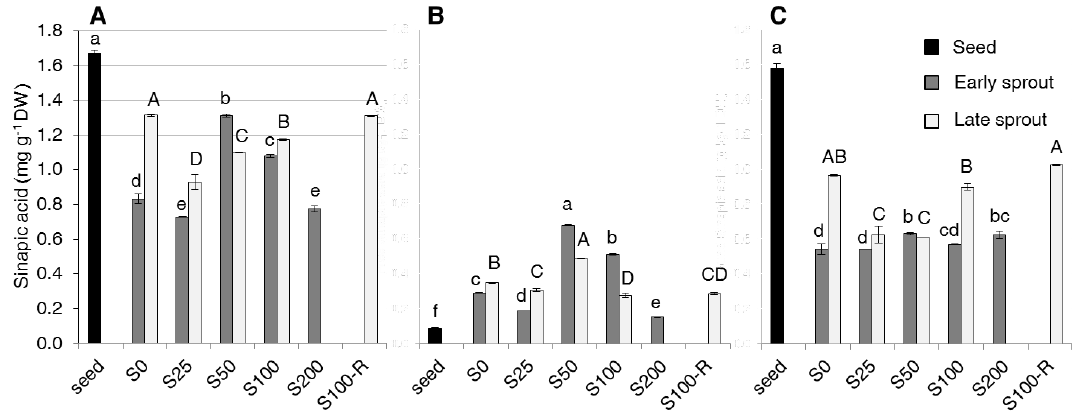
Figure 4. Total ( A ), free ( B ) and bound ( C ) sinapic acid (SA) content (mg g −1 DW) in seeds, early and late sprouts of rapeseed sprouted and grown with salt (NaCl) concentration 0, 25, 50, 100, 200 mM (S0, S25, S50, S100, S200, respectively) or sprouted with 100 mM and then grown with distilled water as recovery treatment (S100-R). Average values of duplicate determinations ± standard error are depicted. Different letters within each graph indicate statistically significant differences at p = 0.05 (Fisher’s LSD). Lower case letters are for comparison within early sprouts; upper case letters for comparison within late sprouts.